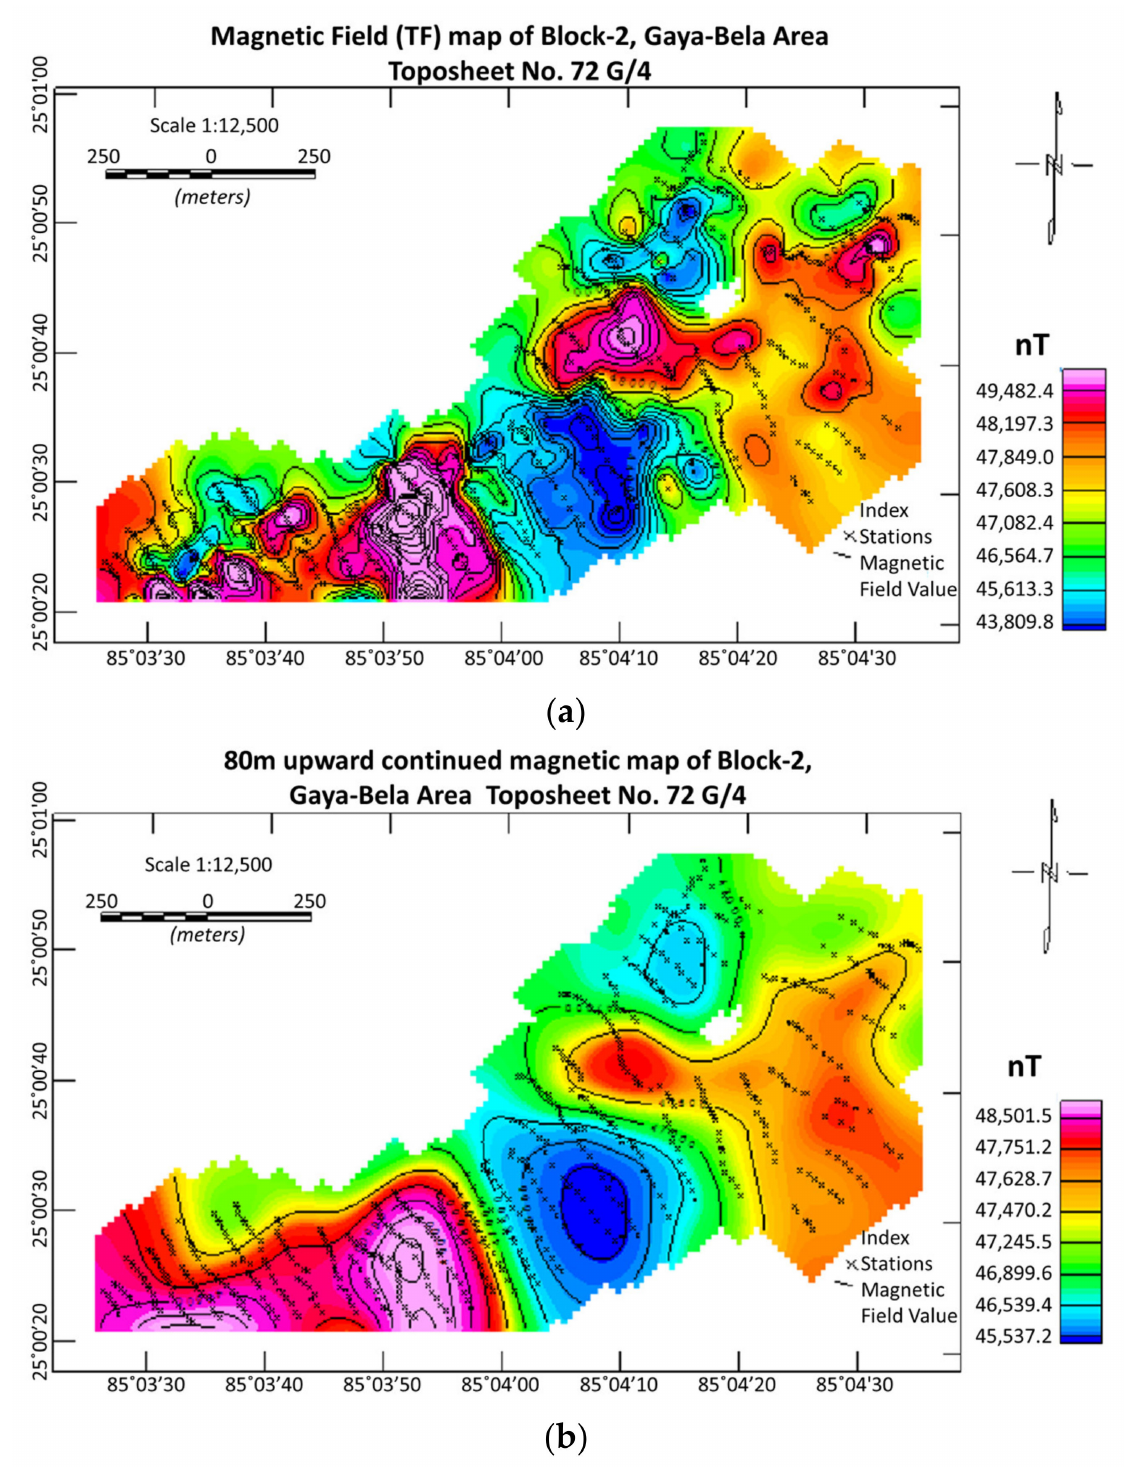
Figure 16. ( a ) Magnetic map (TF) of Block-2, and ( b ) Upward continued magnetic map of Block-2